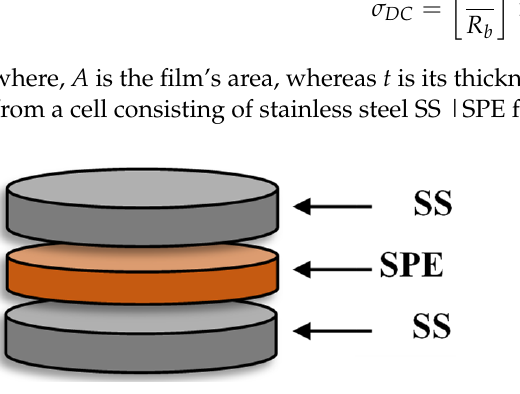
Figure 1. Schematic representation of the cell used to measure conductivity.